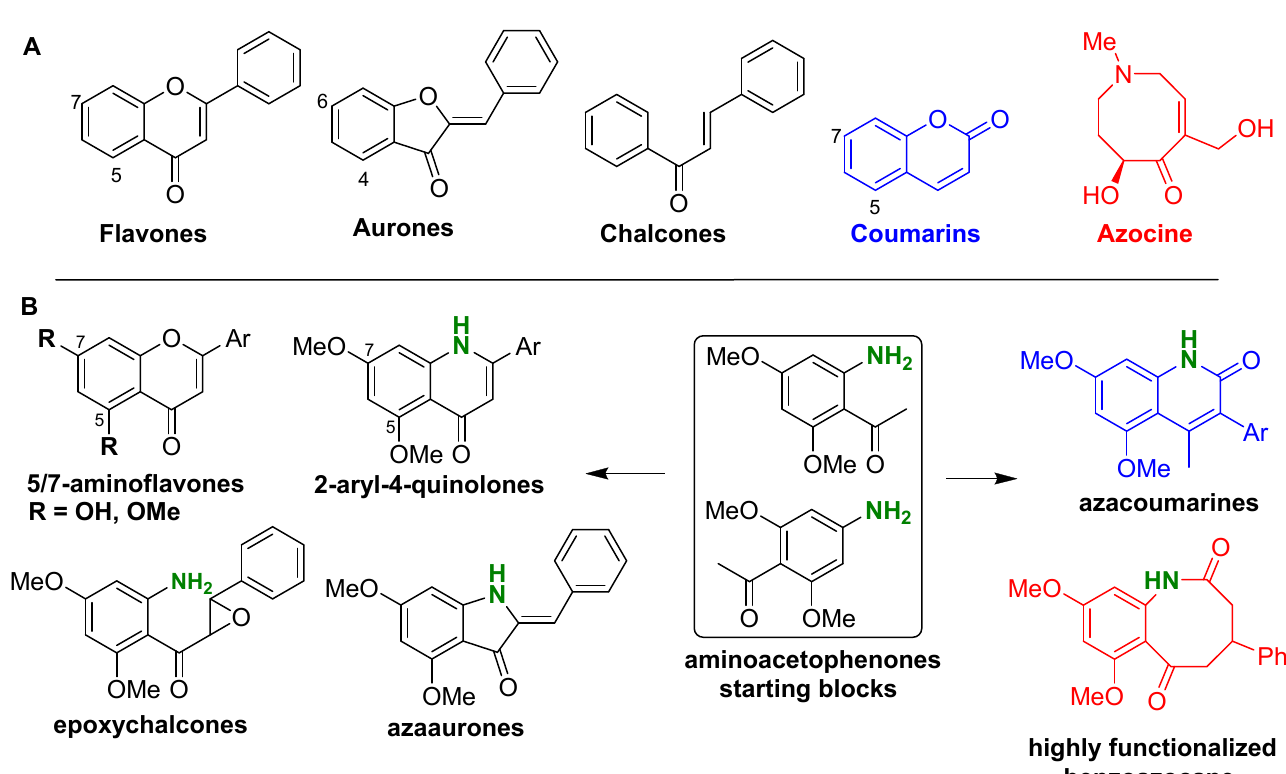
Figure 1. Chemical structures reported in this review. ( A ) General structures of the targeted natural products; ( B ) Structures of the starting blocks and natural product analogs prepared.